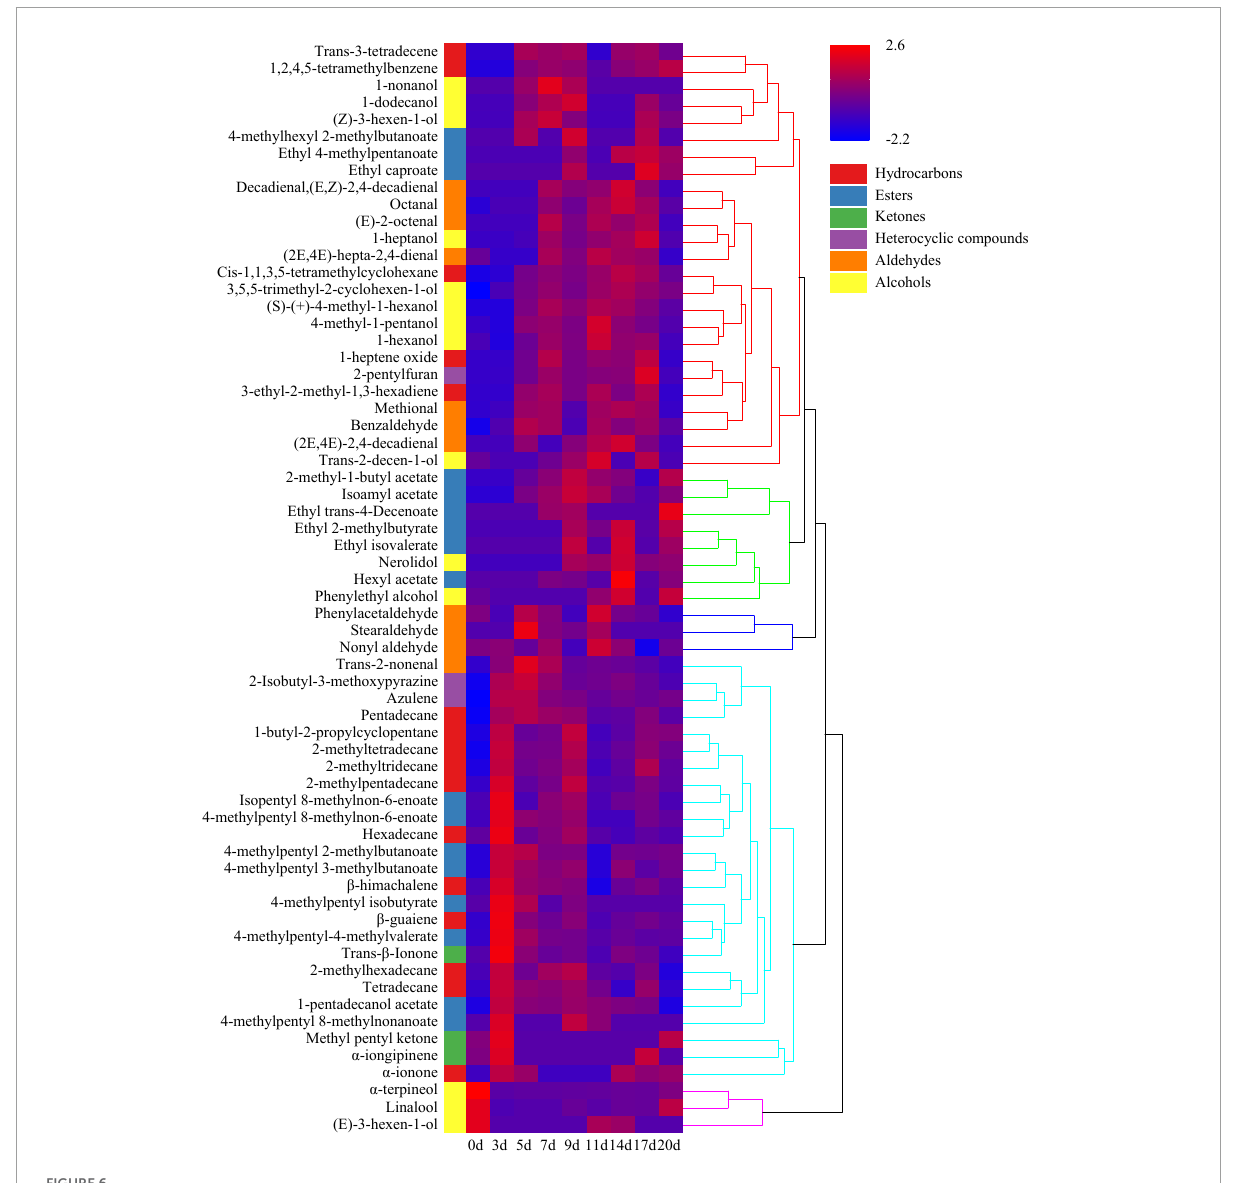
FIGURE6 Hierarchical clustering analysis (HCA) of volatile components during the production of fermented minced peppers. The colors corresponded to normalized mean levels from low (blue) to high